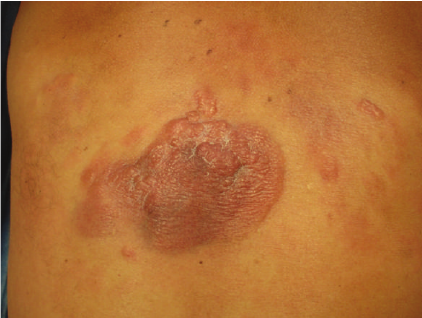
Figure 1: Multiple erythematous to purple, sharply demarcated pruritic nodules in the back that enlarged and coalesced in the last year originating a tumor measuring 11 × 7cm in diameter with some satellite lesions.